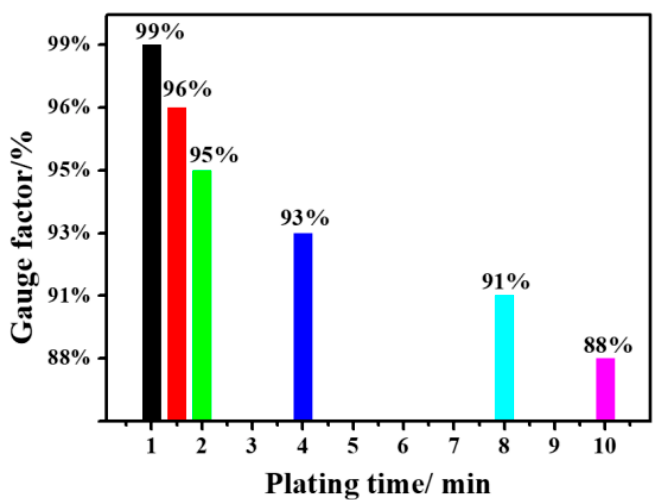
Figure 10. Sponge sensitivity at different plating times.